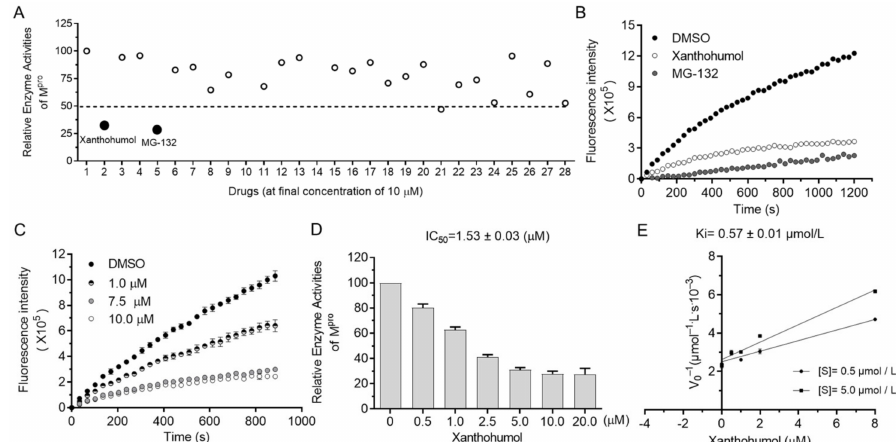
Figure 2. Xanthohumol inhibited hydrolase activities of SARS-CoV-2 M pro in a dose-dependent manner. ( A ) Relative enzyme activities of SARS-CoV-2 M pro in the presence of 10 µ M compounds. ( B ) The kinetic curves in the presence of Xanthohumol, MG132, and the solvent, DMSO. Xanthohumol and MG132 were added to the final concentration of 20 µ M. ( C ) Xanthohumol inhibited M pro dose- dependently. ( D ) The IC 50 value of Xanthohumol. ( E ) The Ki value of Xanthohumol on SARS-CoV-2 M pro . Data are shown as means ± standard error of mean (SEM) from three independent